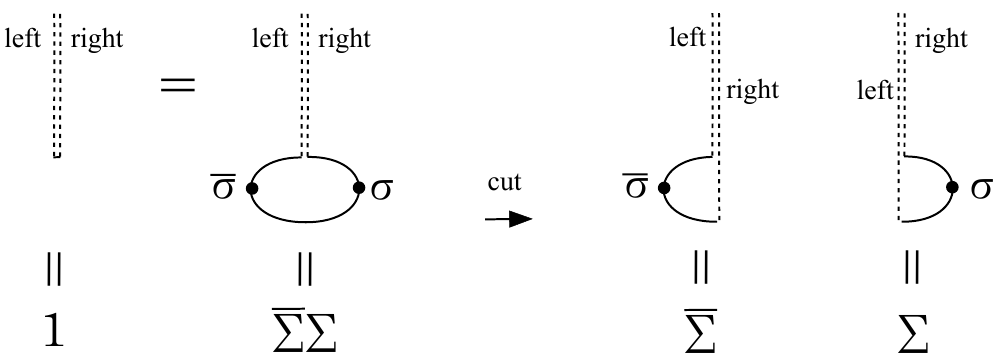
Figure 3 . The boundary point inside the surface of the identity string (cid:12)eld can be replaced with an in(cid:12)nitely narrow neck connecting to a larger region containing (cid:27) and (cid:27) insertions. Cutting the surface in half gives a new representation of (cid:6) and (cid:6) in terms of \(cid:13)ag